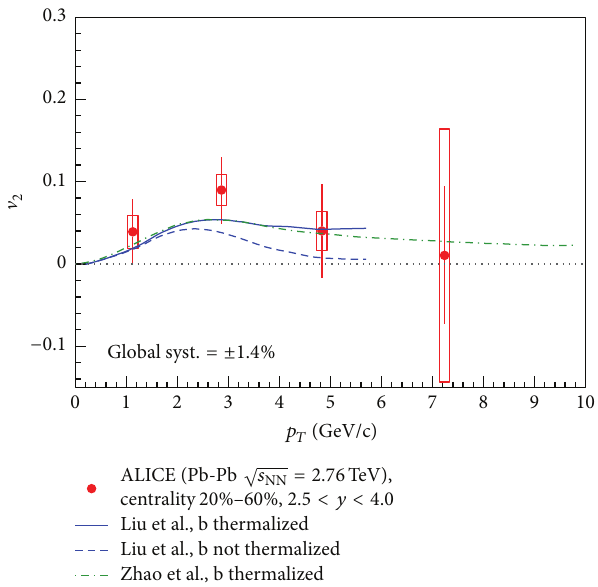
Figure 11: 𝐽/𝜓 V 2 at forward rapidity ( 2.5 < 𝑦 < 4.0 ) for noncentral (20–60%) Pb-Pb collisions at √𝑠 NN = 2.76 TeV